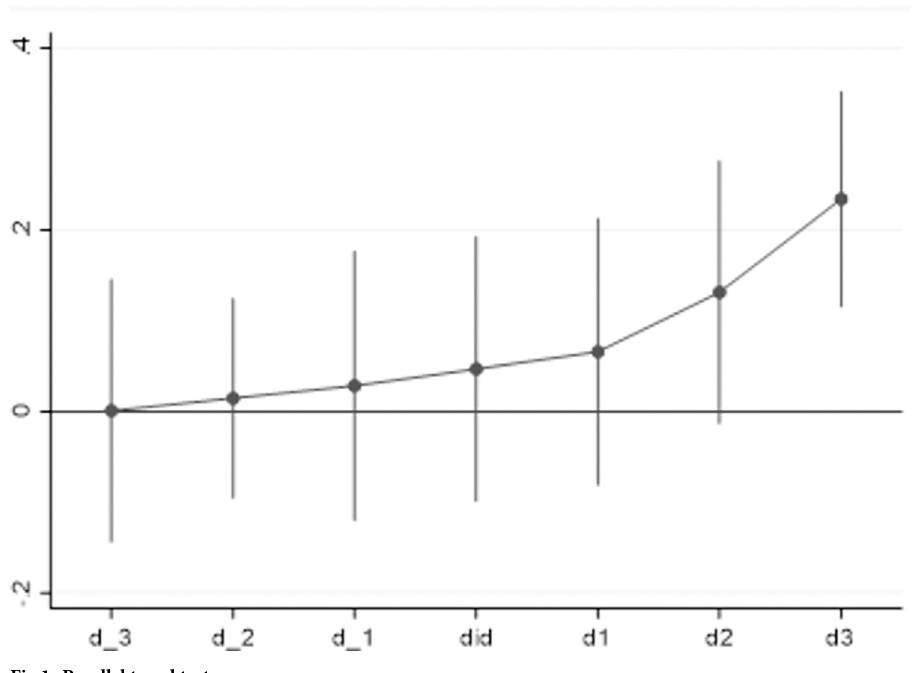
Fig 1. Parallel trend